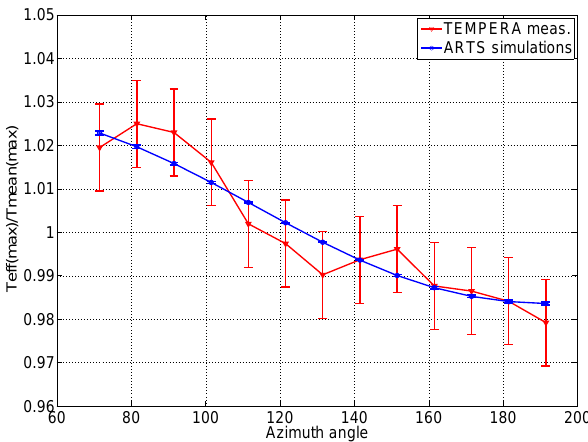
Figure 13. Ratios of maximum brightness temperature of each spectrum to the mean value for all the spectra at the central fre- quencies for TEMPERA radiometer (red points) and ARTS (blue